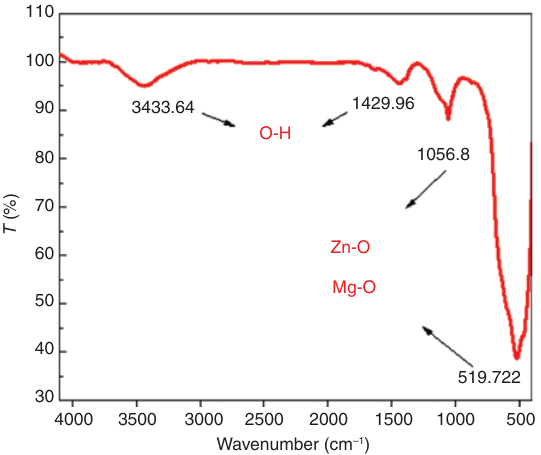
Figure 3: Fourier transform infrared (FT-IR) spectra of Zn 2 + -doped in MgO nanoparticles after calcination at 800 ° C.